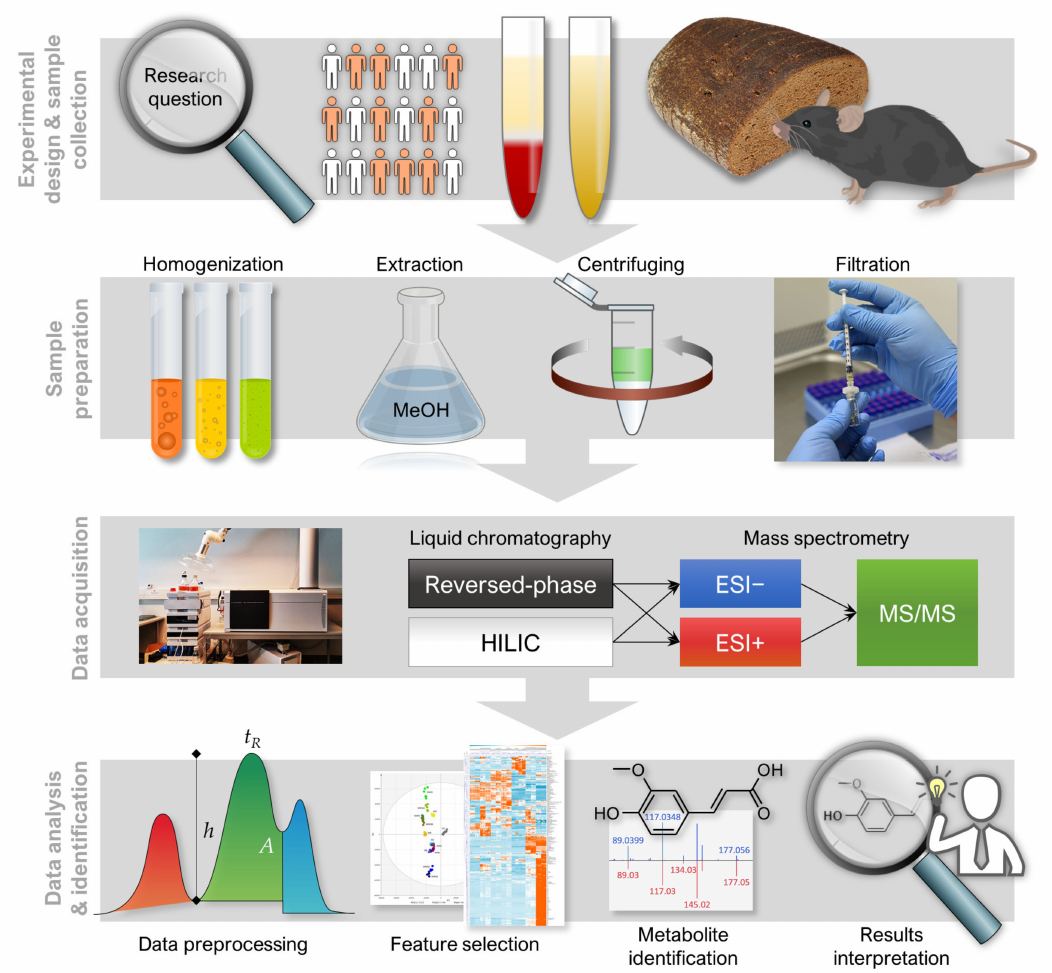
Figure 1. A general overview of notame workflow containing four important stages; 1. Experimental designs and sample collection, 2. sample preparation, 3. data acquisition, 4. data analysis and biomarker identification